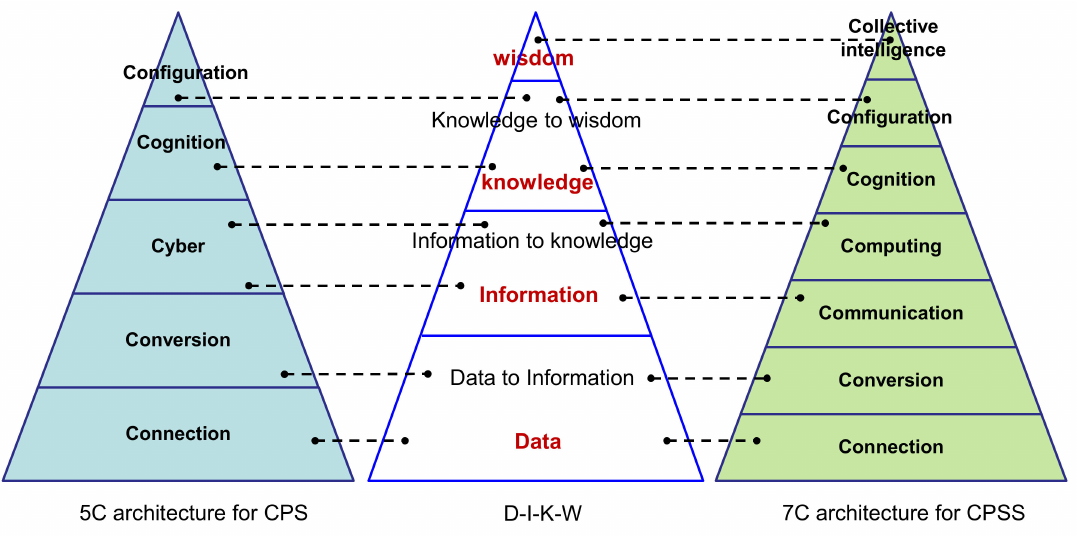
Figure 2. 7C level model for